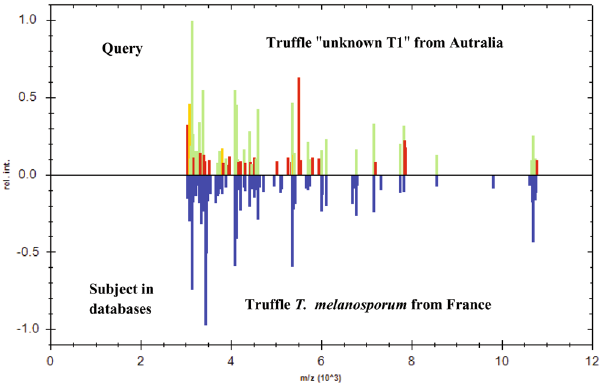
Figure 3. Rapid identification of the blind-coded truffle from Australia using the MALDI Biotyper search algorithm against databases containing reference MS spectra of archaea, bacteria and eukaryota including truffles. The first best hit corresponds to the MS spectrum of T . melanosporum species from France (score